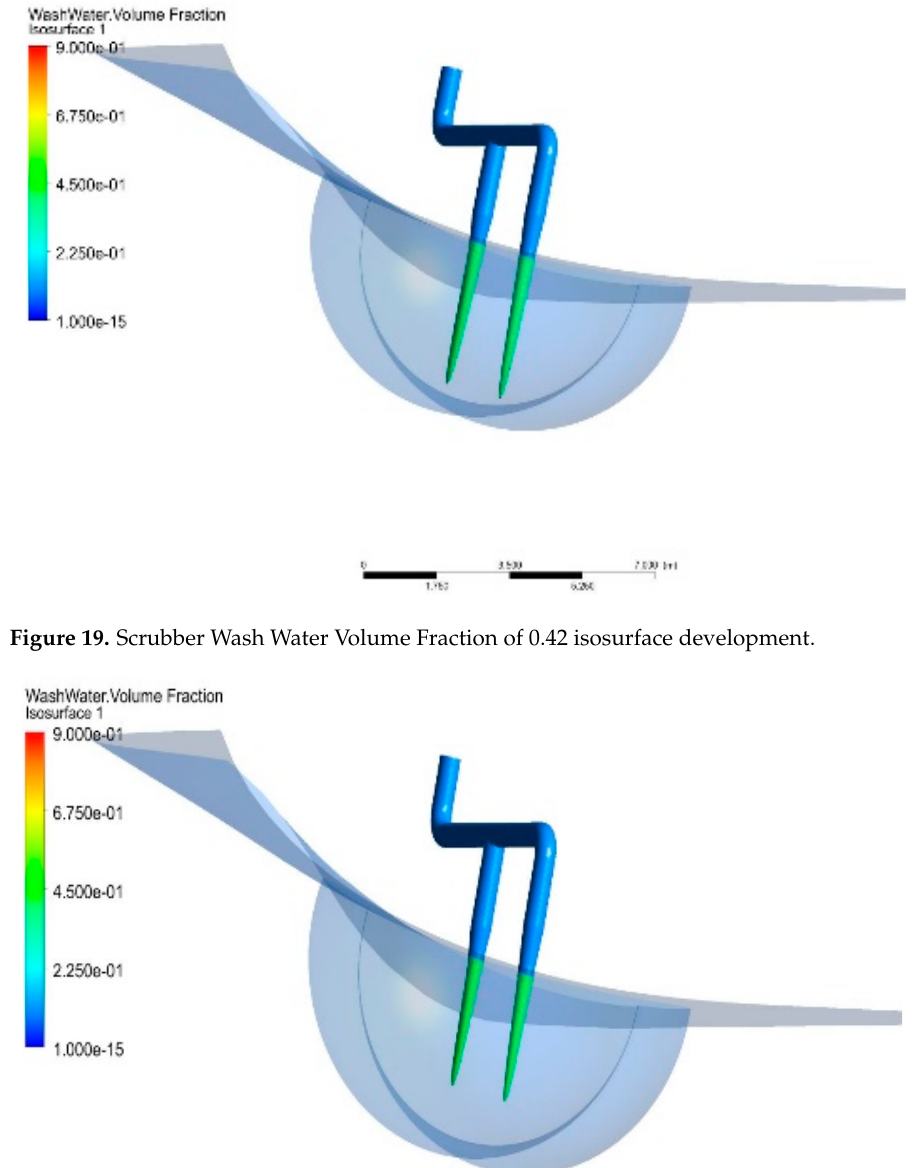
Figure 18. Scrubber Wash Water Volume Fraction of 0.41 isosurface development—probe sphere detail.